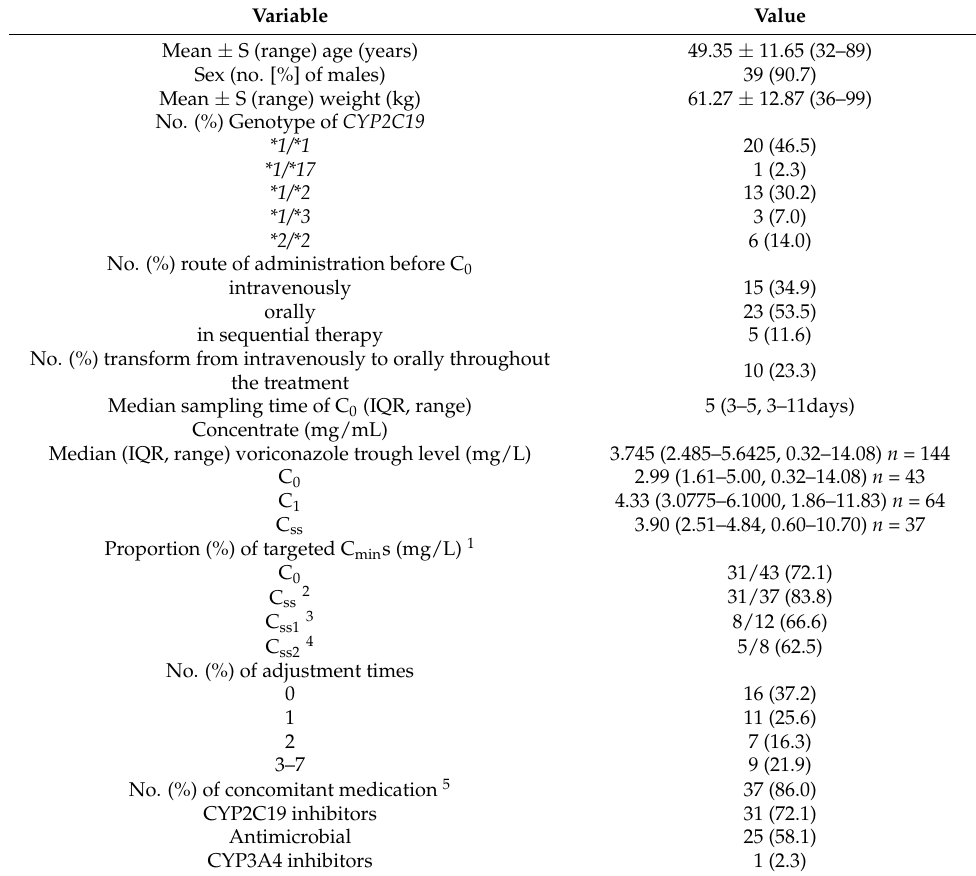
Table 1. Demographic, clinical data and voriconazole regimen for 43 CP-C patients with therapeutic drug monitoring of voriconazole.